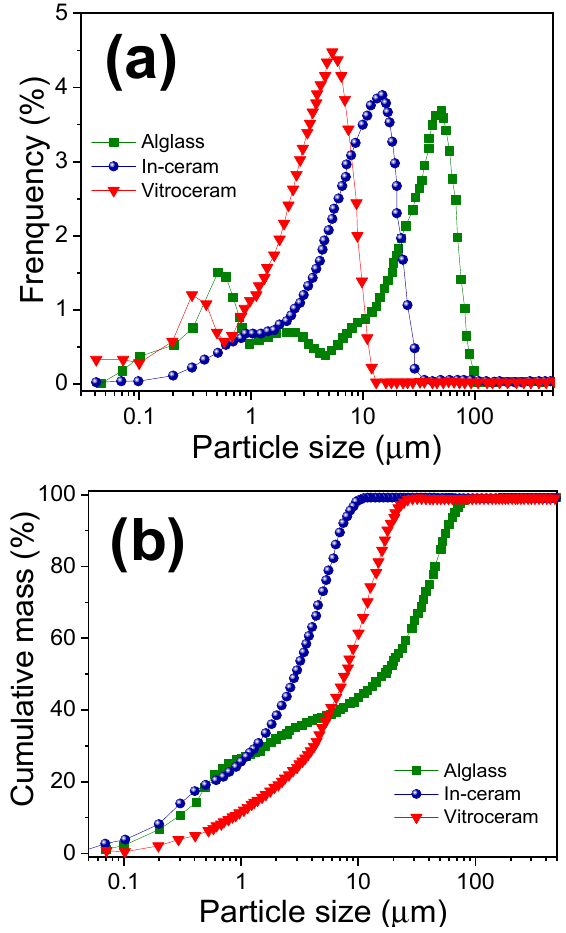
Figure 4. ( a ) Distribution and ( b ) cumulative mass of particle size of Alglass, In-ceram and Vitro- ceram